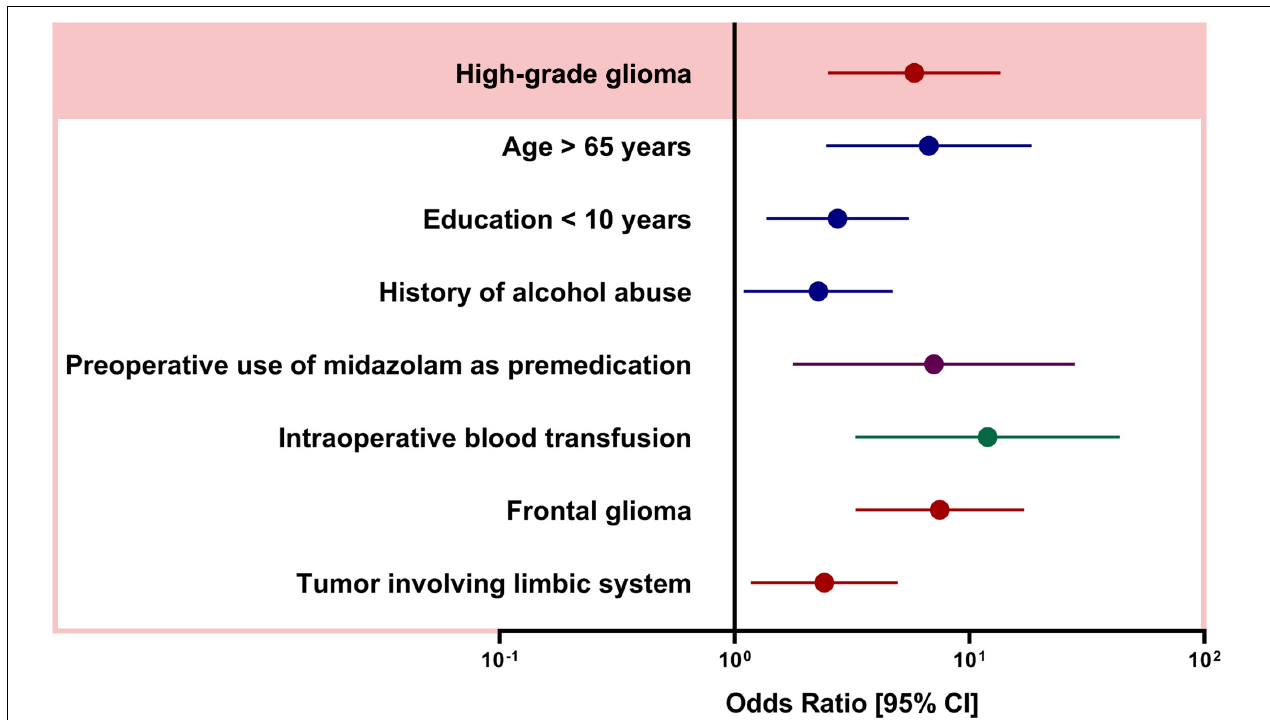
FIGURE 1 | Adjusted odds ratios (OR) from multivariable logistic regression. OR and [95% CIs] are calculated from the model described in Methods.